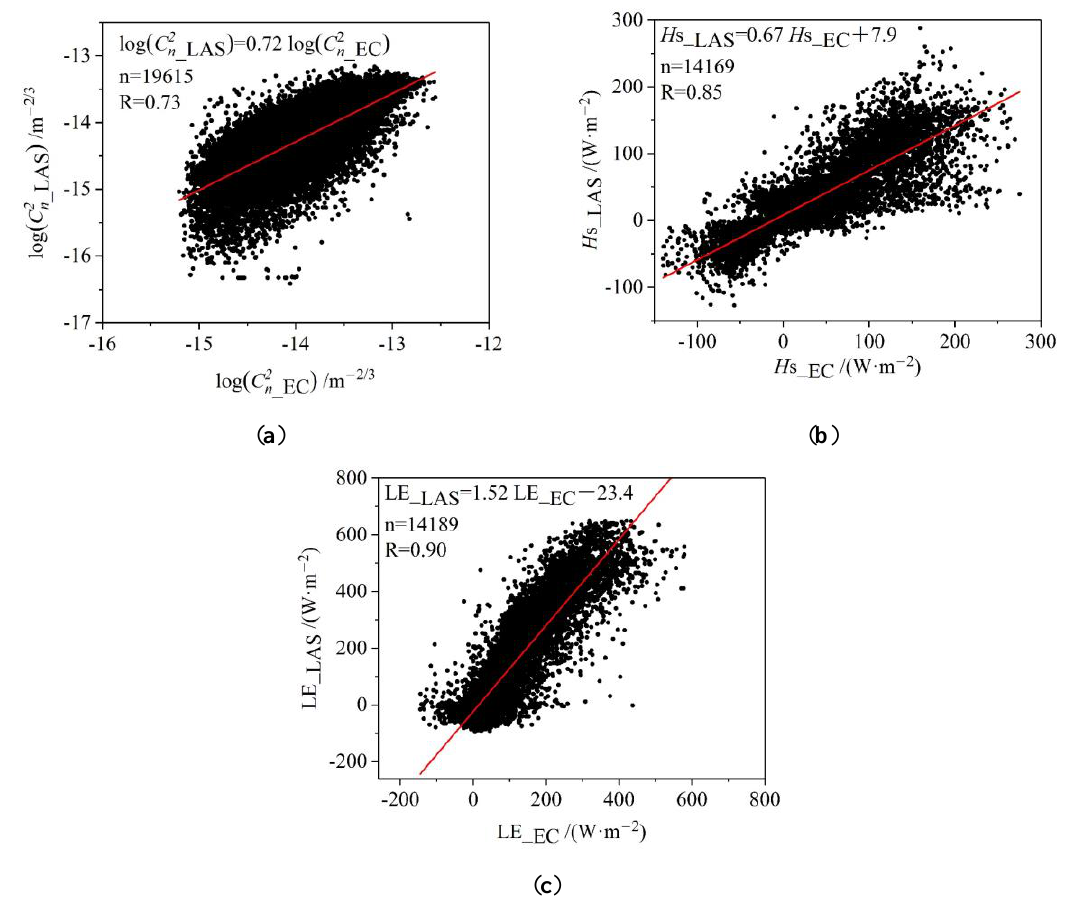
Figure 5. Scatter plot of the structure parameter of the refractive index of air ( C n 2 ) ( a ) as well as sensible heat ( H s) ( b ) and latent heat (LE) ( c ) fluxes and measured with LAS and EC (adapted from [47,48]).